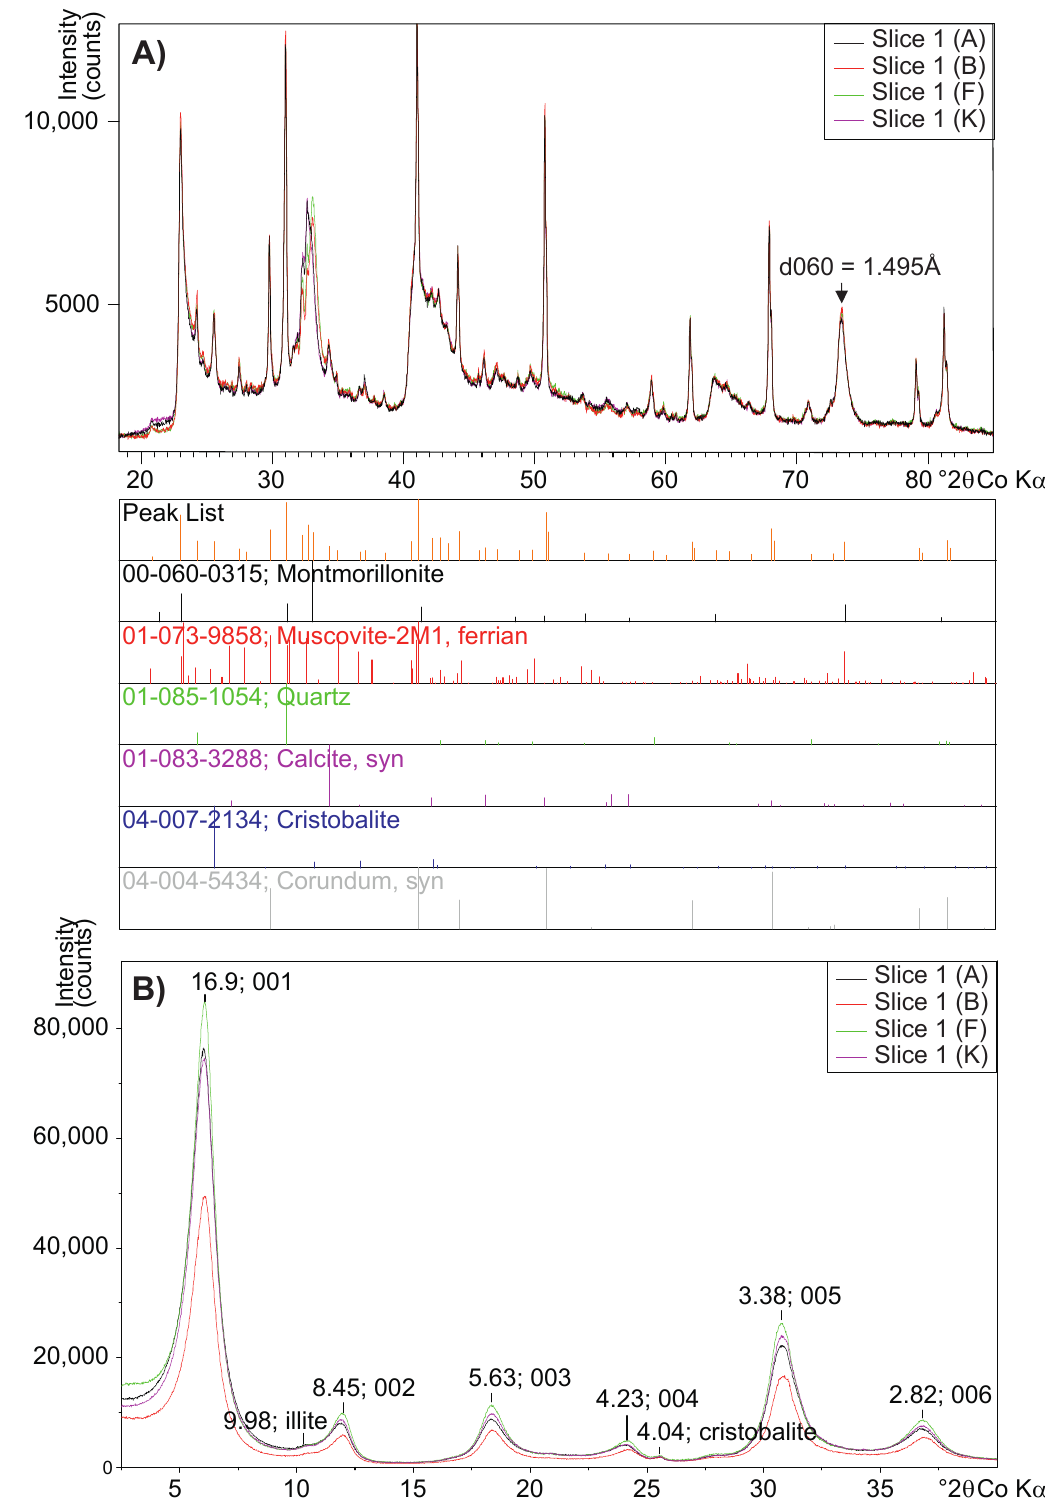
Figure 10. ( A ) Whole-rock powder XRD traces for selected Ca-bentonite subsamples showing the similarity of the traces and the diagnostic dioctahedral smectite d060 peak spacing at 1.495 Å. The lower part of the figure shows the extracted peak positions and intensities (shown orange) compared to similar data for the identified International Centre for Diffraction Data (ICDD) mineral standards. ( B ) < 2 µ m ethylene glycol-solvated oriented mount XRD traces for the same selected Ca-bentonite subsamples showing the very similar positions of the smectite peak positions (labelled with their appropriate 00l and d spacing in